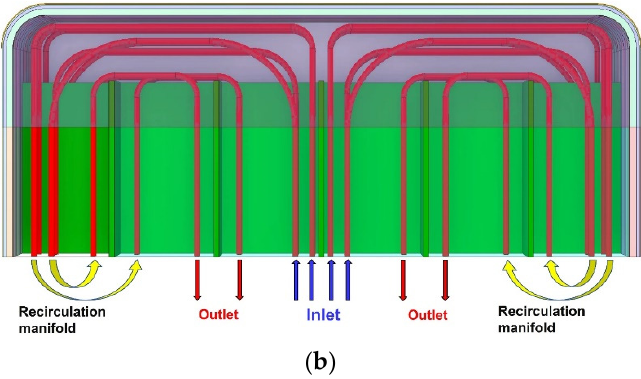
Figure 3. ( a ) Schematic of the side FW to show the counter ‐ current cooling system. ( b ) Double loop circuit for the BZ cooling water. circuit for the BZ cooling